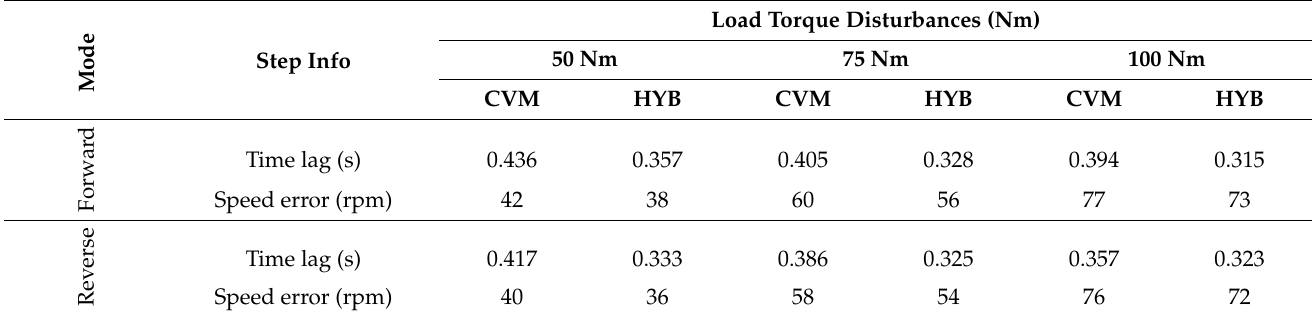
Table 7. Rotor speed performance under load torque disturbances.